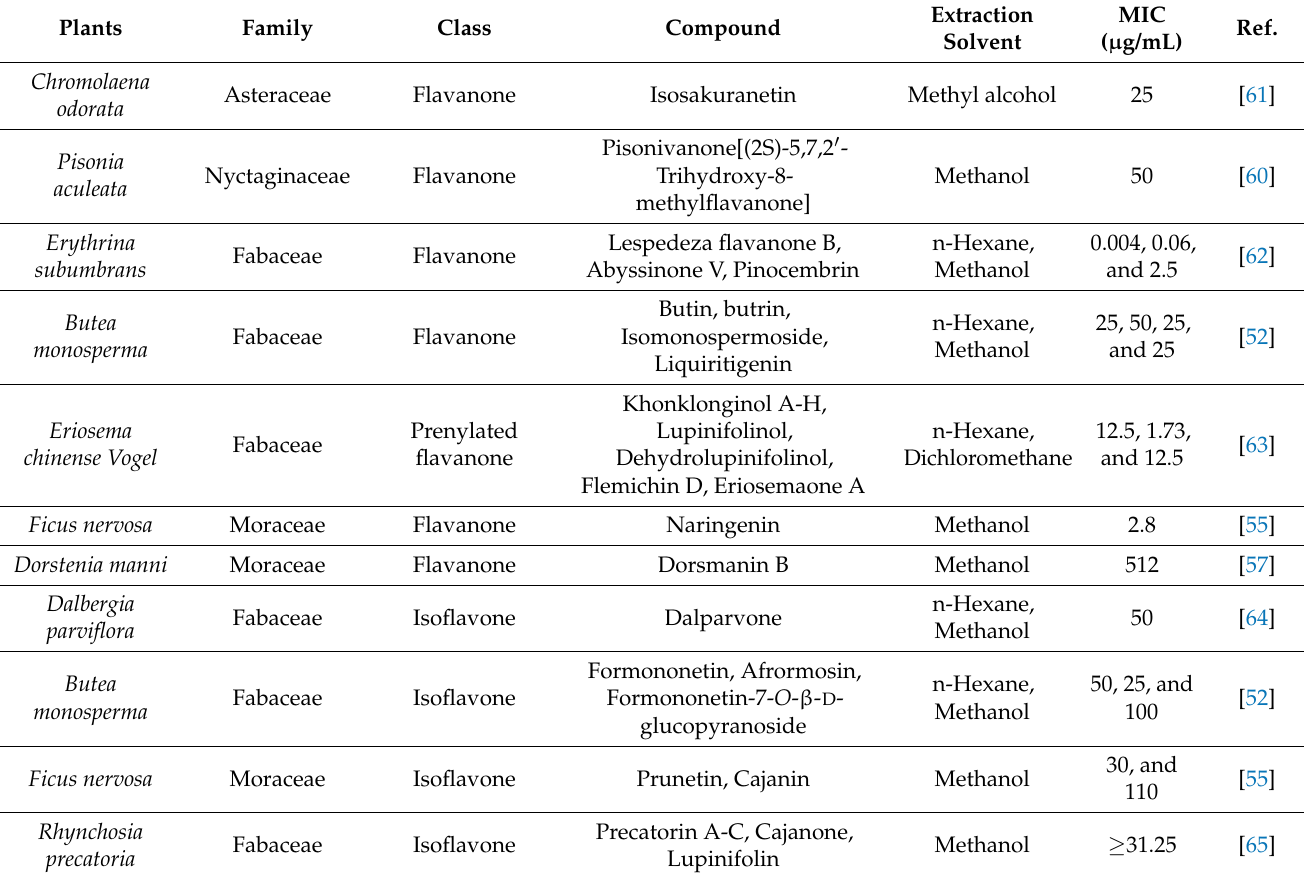
Table 2. List of anti-tuberculosis flavanones and isoflavones extracted from various